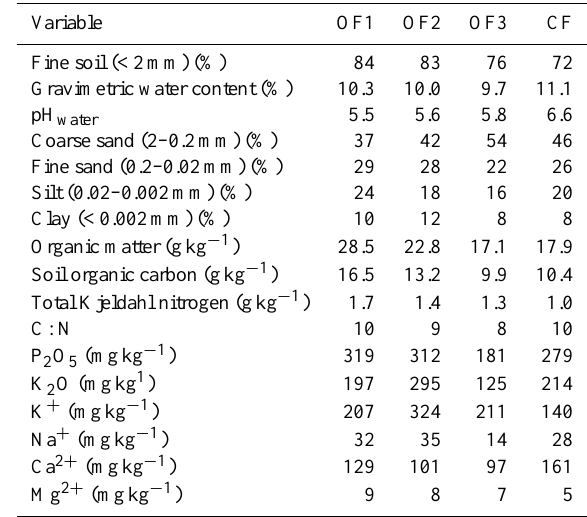
Table 1. Topsoil (0–20cm) properties of the three plots under organic farming (OF) and of the plot under conventional farm- ing (CF). Previous crop/fertilizer: alfalfa/alfalfa green manure for OF1, corn/organic compost for OF2; corn/no fertilizer for OF3; corn/chemical fertilizer for CF.